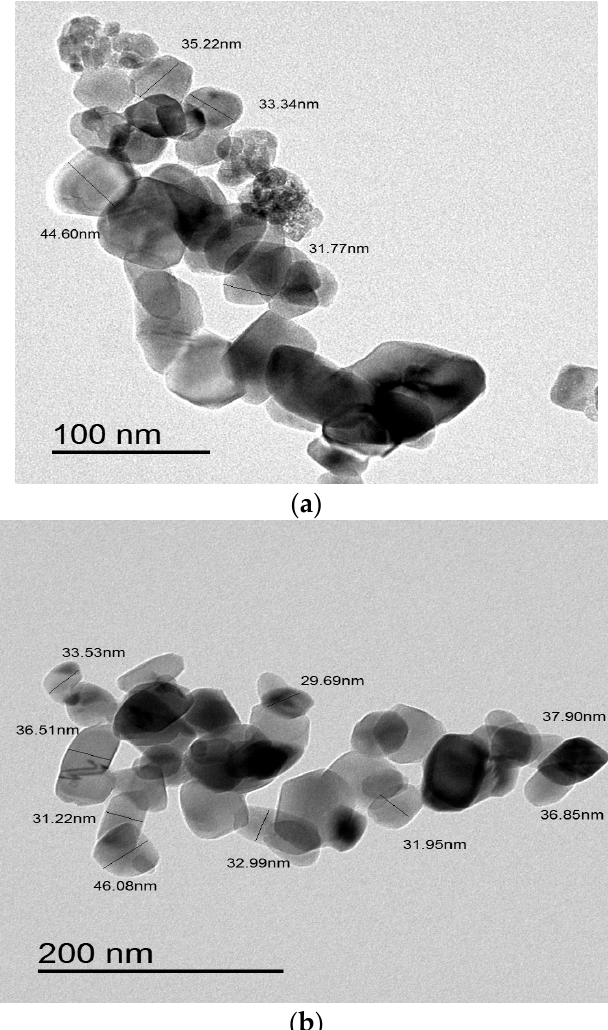
Figure 5. ( a , b ) Transmission Electron microscope (TEM) of titanium nanostructures TiO 2 -NPs (100 and 200 nm).